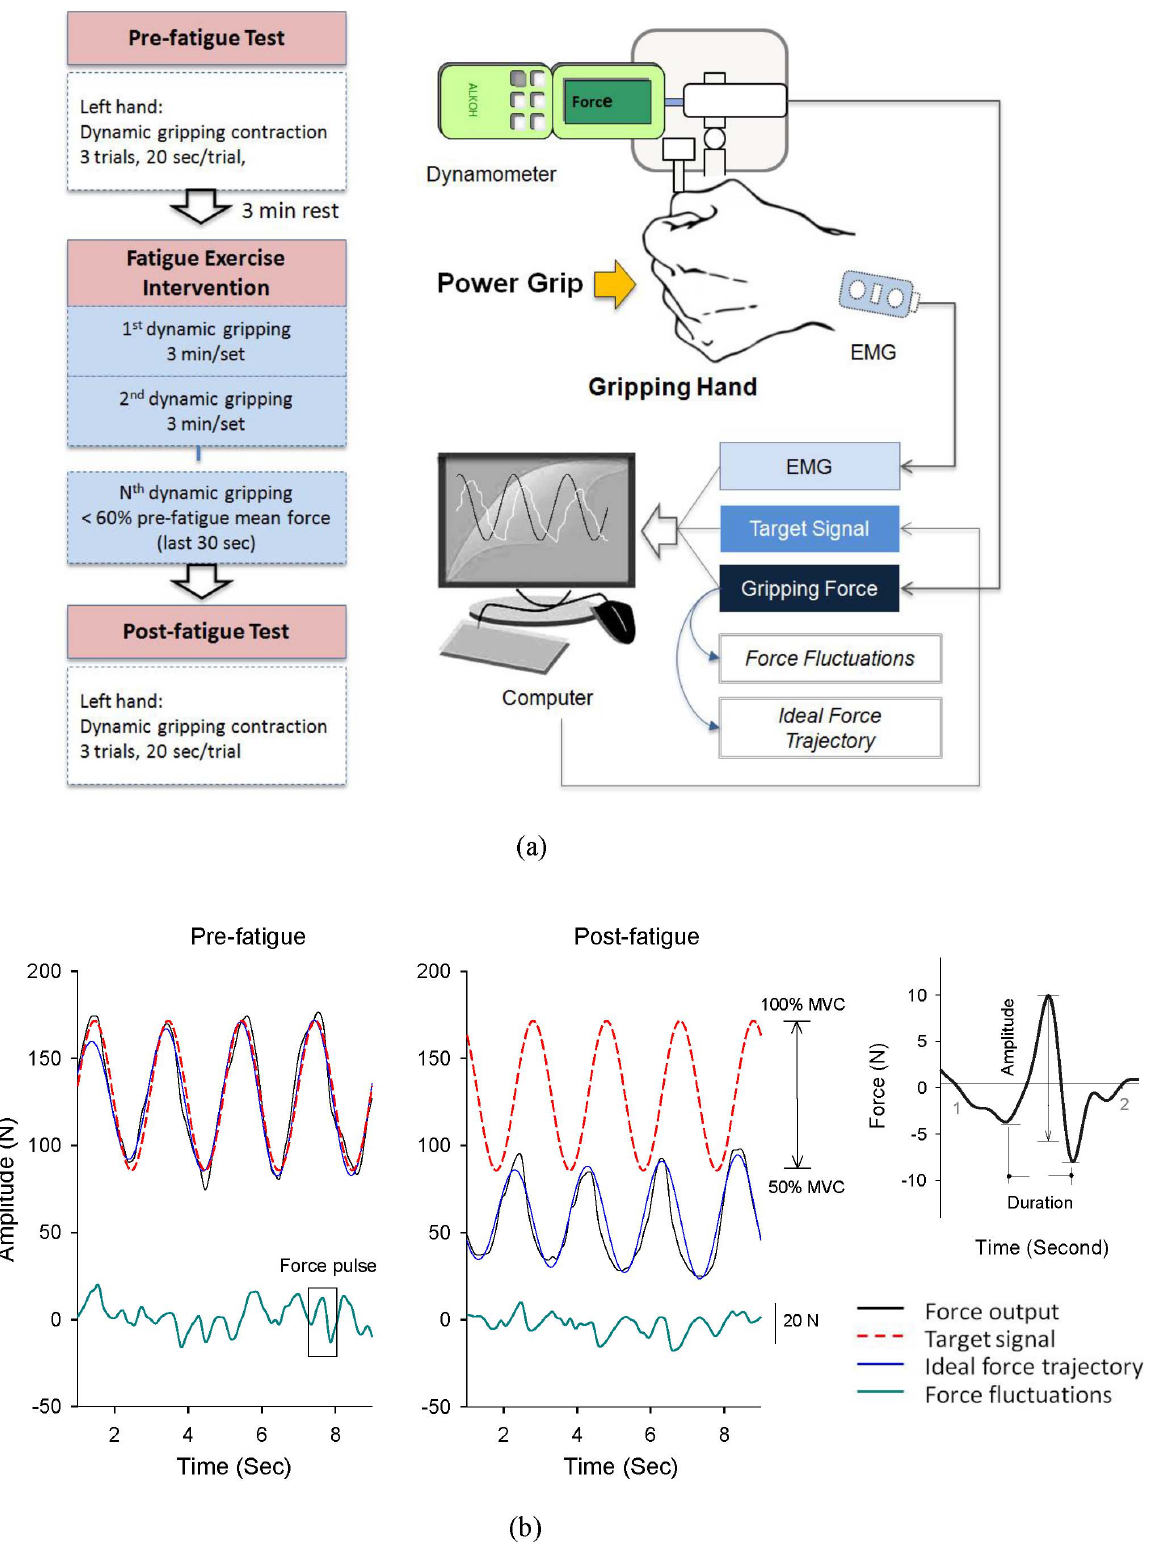
Figure 1. Experiment procedure, system setup, and data recording. (a) Schematic diagrams of the apparatus and fatigue protocol, (b) Typical recordings of force and target signals in the pre-fatigue and post-fatigue tests. The force signal was decomposed into a ideal force trajectory and a force pulse trace, visibly smaller after fatiguing contraction. Measures of amplitude and duration of a force pulse in the force pulse trace are displayed.